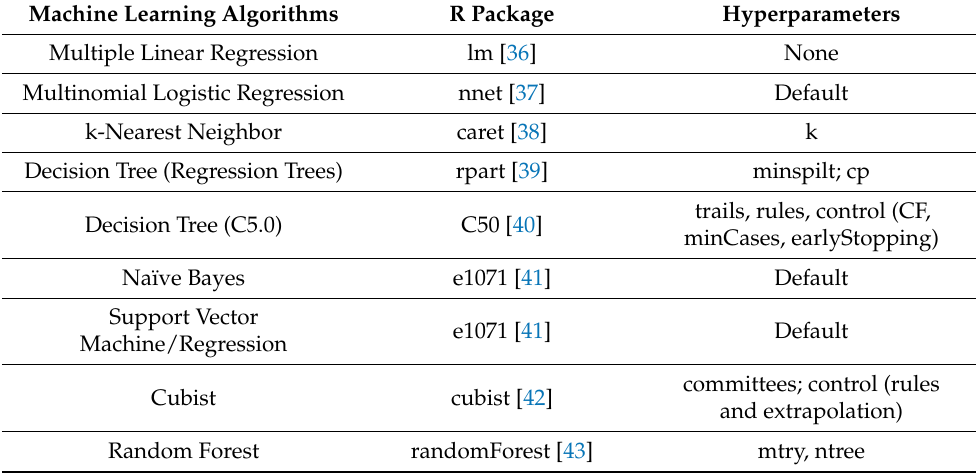
Table 2. Machine learning algorithms utilised for comparison along with their hyperparameters. Machine Learning